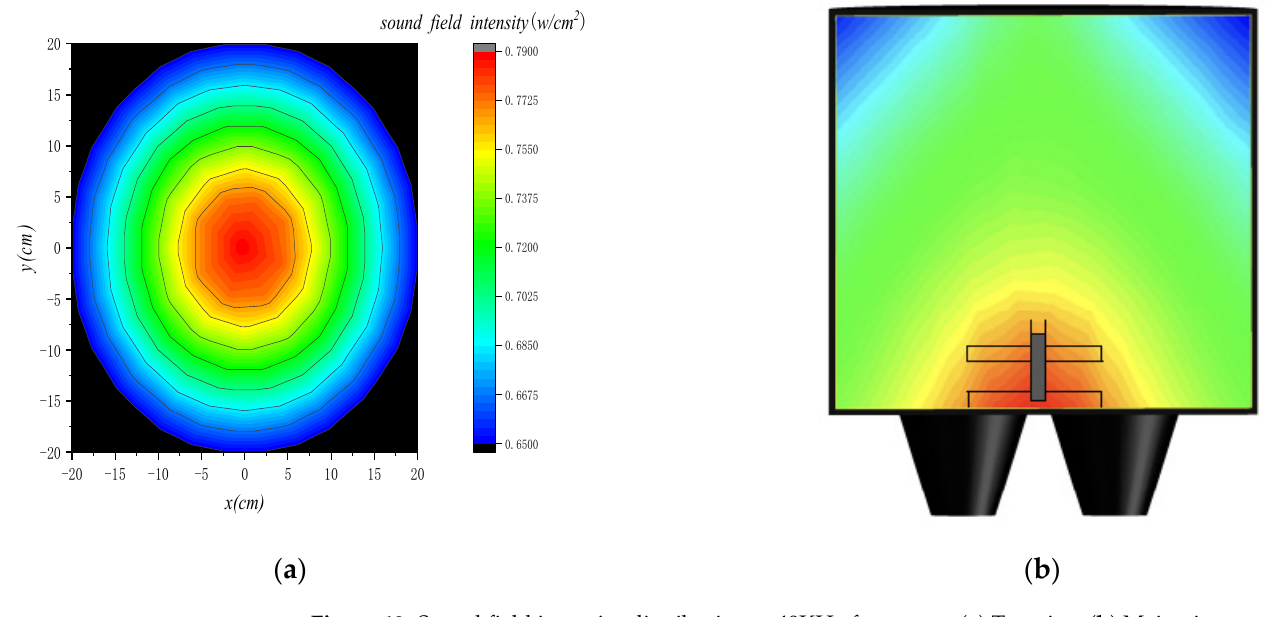
Figure 12. Sound field intensity distribution at 40KHz frequency. ( a ) Top view ( b ) Main view